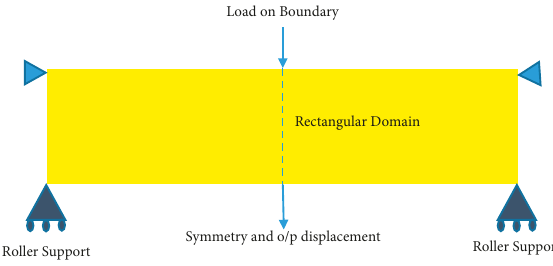
Figure 2: Boundary conditions —rectangular